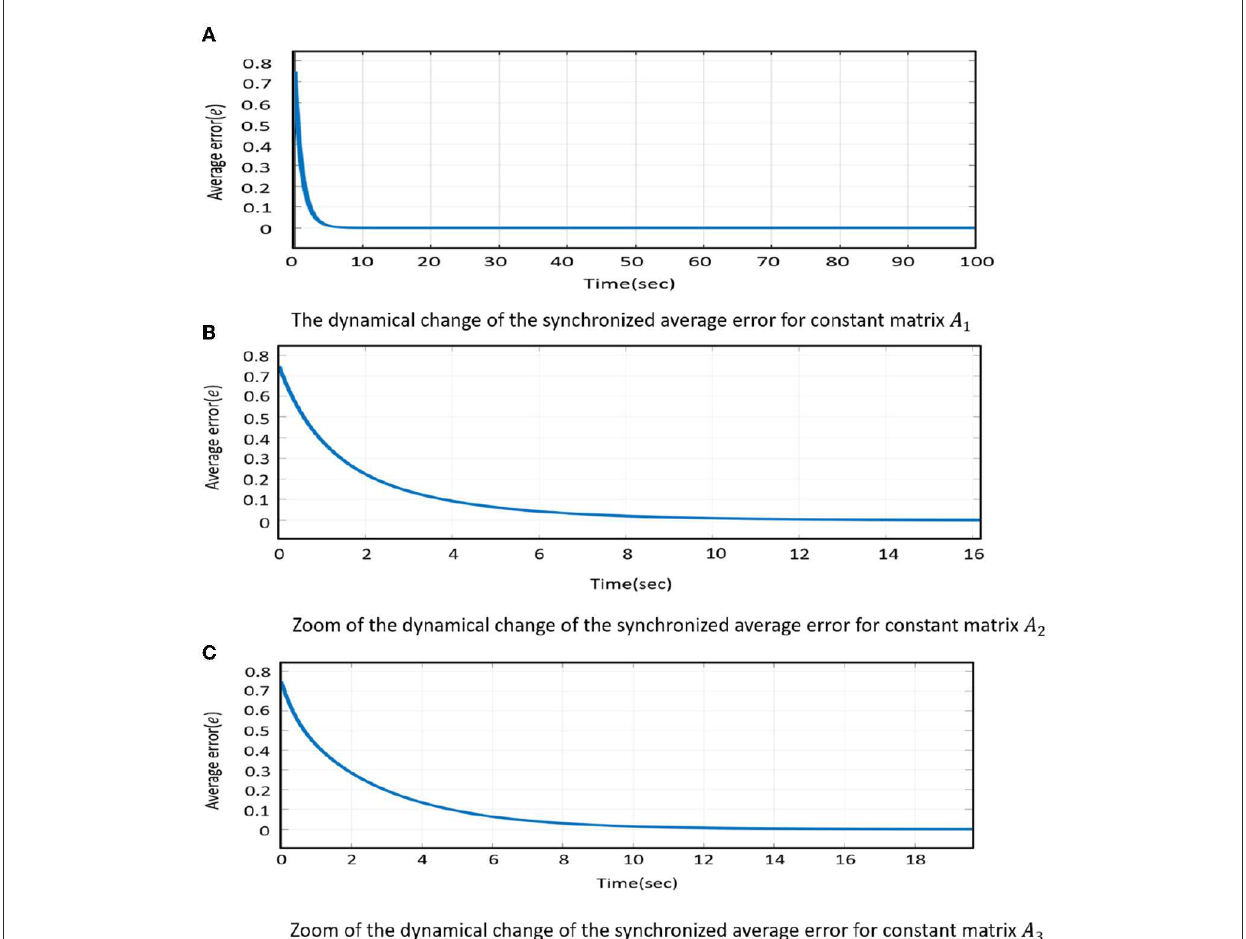
FIGURE6 The dynamical change of the synchronized average error when we chose arbitrary matrix ( A 1 , A 2 , A 3 ) for the control function. (A) To carry out the zoom of the dynamical change of the synchronized average error for constant matrix A 1 . (B) Zoom of the dynamical change of the synchronized average error for constant matrix A 2 . (C) Zoom of the dynamical change of the synchronized average error for constant matrix A 3